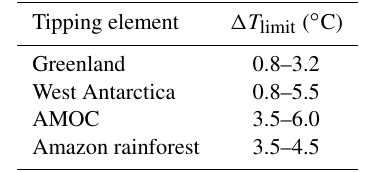
Table 1. Nodes in the modelled network of interacting tipping ele- ments. For each tipping element in the network (see Fig. 1), a range of critical temperatures (cid:49)T limit is known from a review of the liter- ature (Schellnhuber et al., 2016). Within this temperature range, the tipping element is likely to undergo a qualitative state